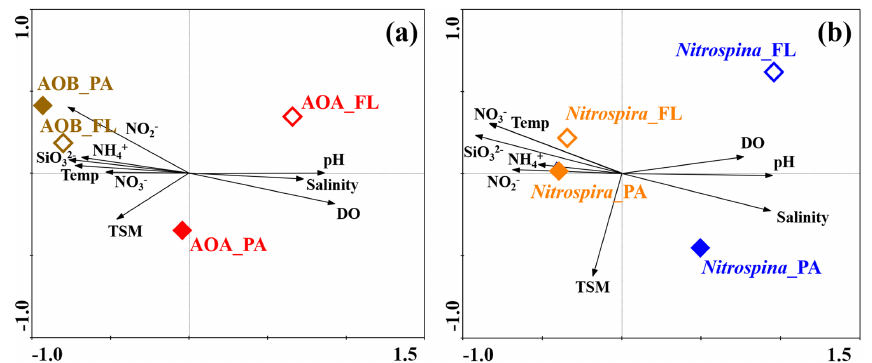
Figure 9. Canonical correspondence analysis. (a) Ammonia and (b) nitrite oxidizers under the constraint of environmental factors. Each diamond represents an individual subgroup. Vectors represent the environmental variables. Temp stands for